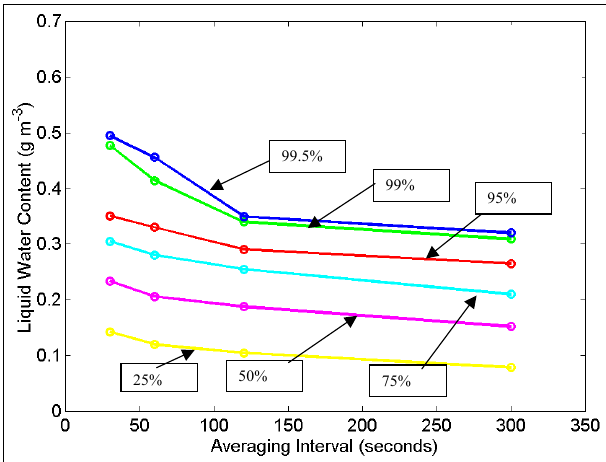
Fig. 4. Relationship between averaged LWC and averaging scale for different percentiles for the AIRS data set. The Convair-580 flies at approximately 100ms − 1 , which means the 30-s, 60-s, 120-s, and 300-s averages represent scales of 3km, 6km, 12km, and 30km, respectively.